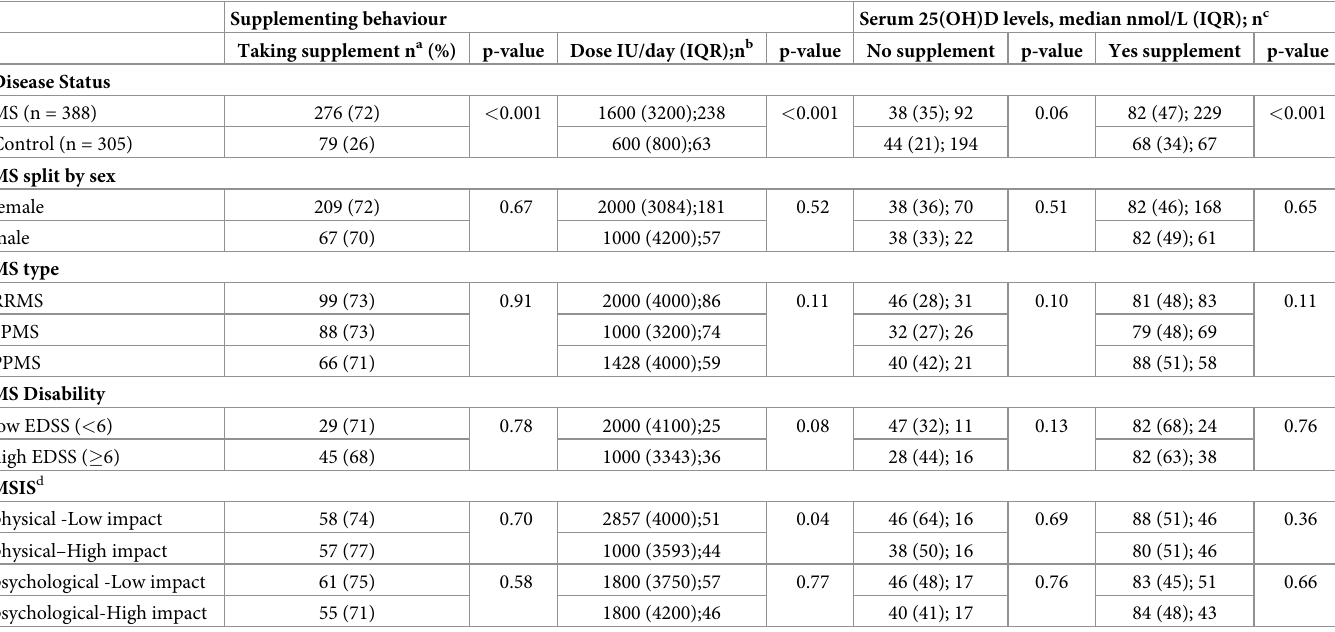
Table 2. Vitamin D supplementation behaviour and serum 25-(OH)D levels in the biological sampling group. Supplementing